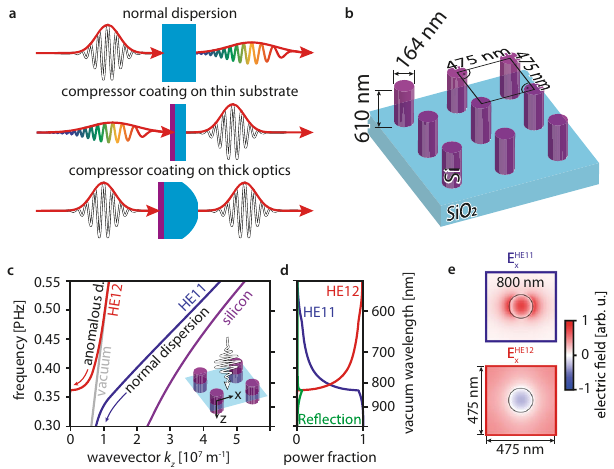
Fig. 1 Nanocoating compressor working principle and design. a Chromatic dispersion effect on ultrashort laser pulses in transparent materials and possible coating applications. Short pulses are marked in white, pulses stretched by material dispersion in colors; normally dispersive materials (light blue) elongate short pulses. The coating (purple) can either be applied to a thin substrate to shorten elongated pulses or to a thick optics to compensate for its group delay dispersion. b Design optimized for operation at 800 nm wavelength. c Dispersion of the predominant modes calculated for a two-dimensional cross-section (illustrated in the inset) perpendicular to the light propagation direction. The modes are labeled with the names of hybrid fi ber modes with the same symmetry (HE11-like: blue line, HE12-like: red line). The vacuum (gray line) and silicon dispersions (purple line) are also plotted. One should note that the HE12- like mode ’ s propagation constant is real above the vacuum line because light leaking out of a single nanopillar is not lost from the array. The mode ’ s wavevector along the propagation direction k z vanishes ( k z ¼ 0) at a frequency of 0.36 PHz (825 nm). As this cutoff is approached, the group velocity decreases (slow light), creating a region with anomalous group velocity dispersion (see red arrow marked anomalous d.) d Power coupling fraction from free space to the HE11-like and HE12-like modes. The transition from light propagating in the HE12-like to the HE11-like mode at 0.36 PHz (825 nm) increases the working bandwidth. Power re fl ected by the compressor is plotted in green. e Transverse electric fi eld distributions of the modes at 800 nm wavelength. Whereas the HE11-like mode has no in fl ection points, the HE12-like mode has one in fl ection